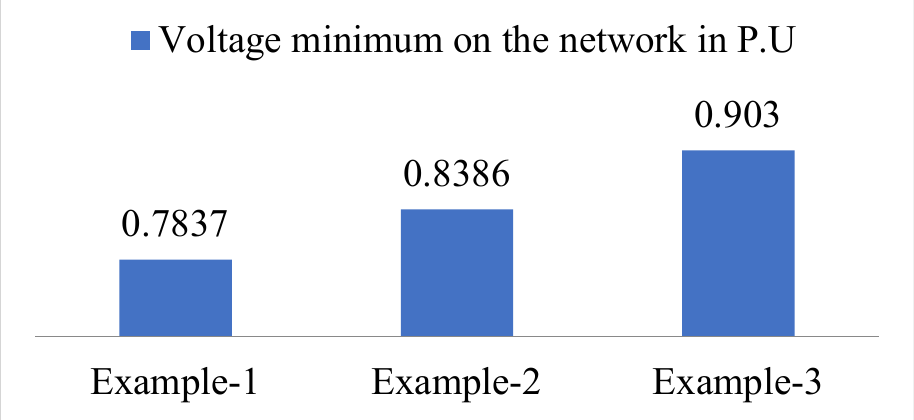
Figure 10. Voltage profile comparison in different study examples of the IEEE-34 bus URDN.